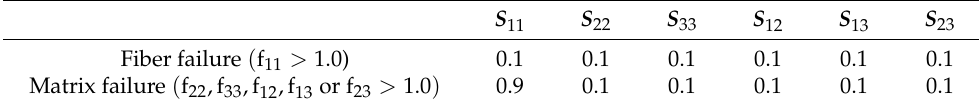
Table 1. How reduction factors are changed depending on failure criterion. S 11 S 23 Fiber failure ( f 11 >